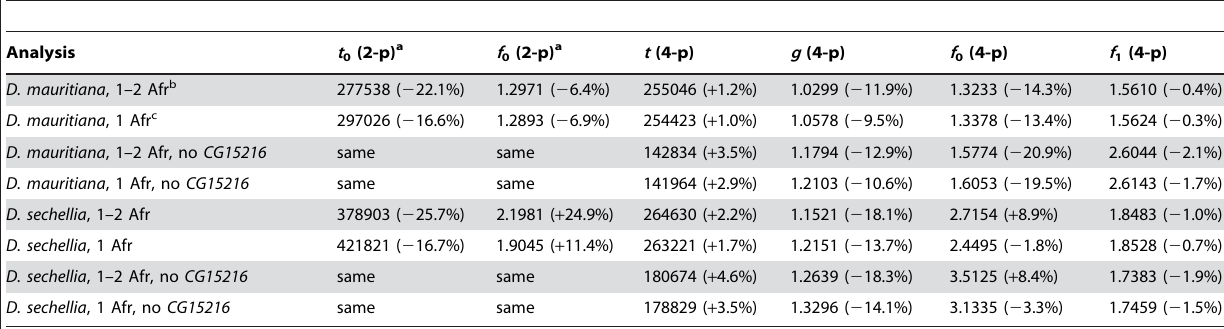
Table 6. Parameter estimates following inclusion of additional D. simulans data from African lines.